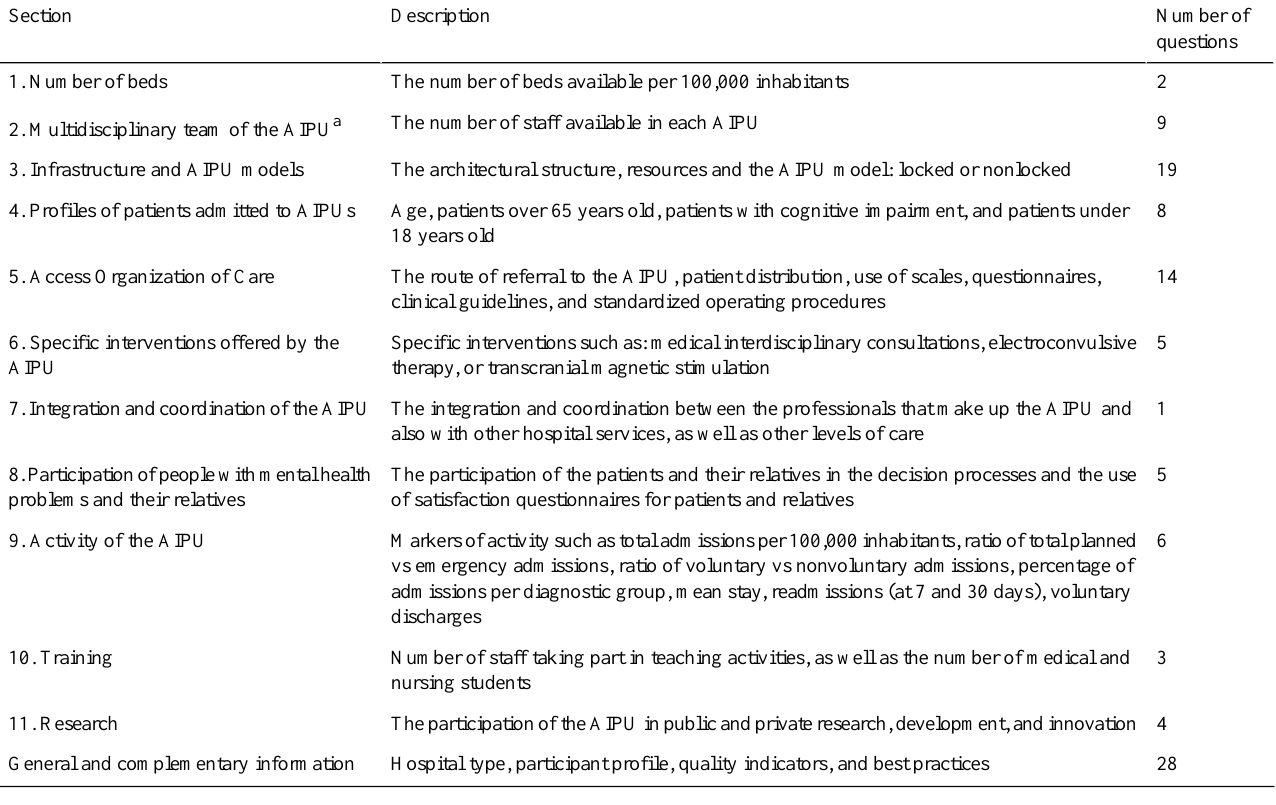
Table 1. Survey sections and number of